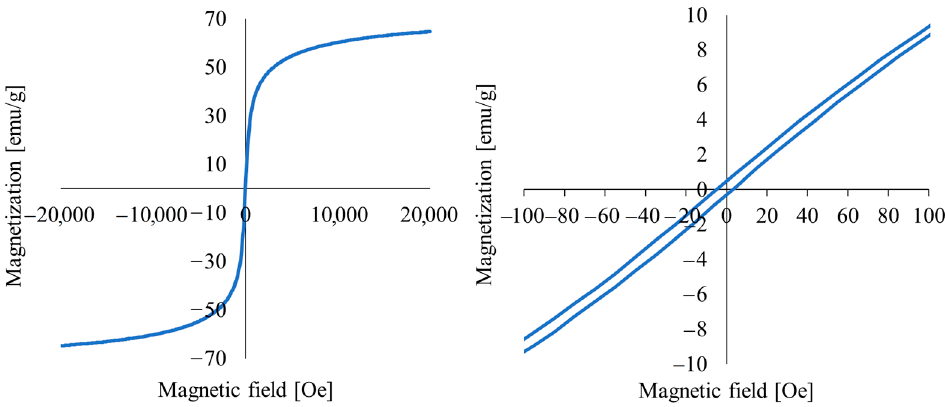
Figure 9. The hysteresis loop of the resulting MIONs (sample S9).